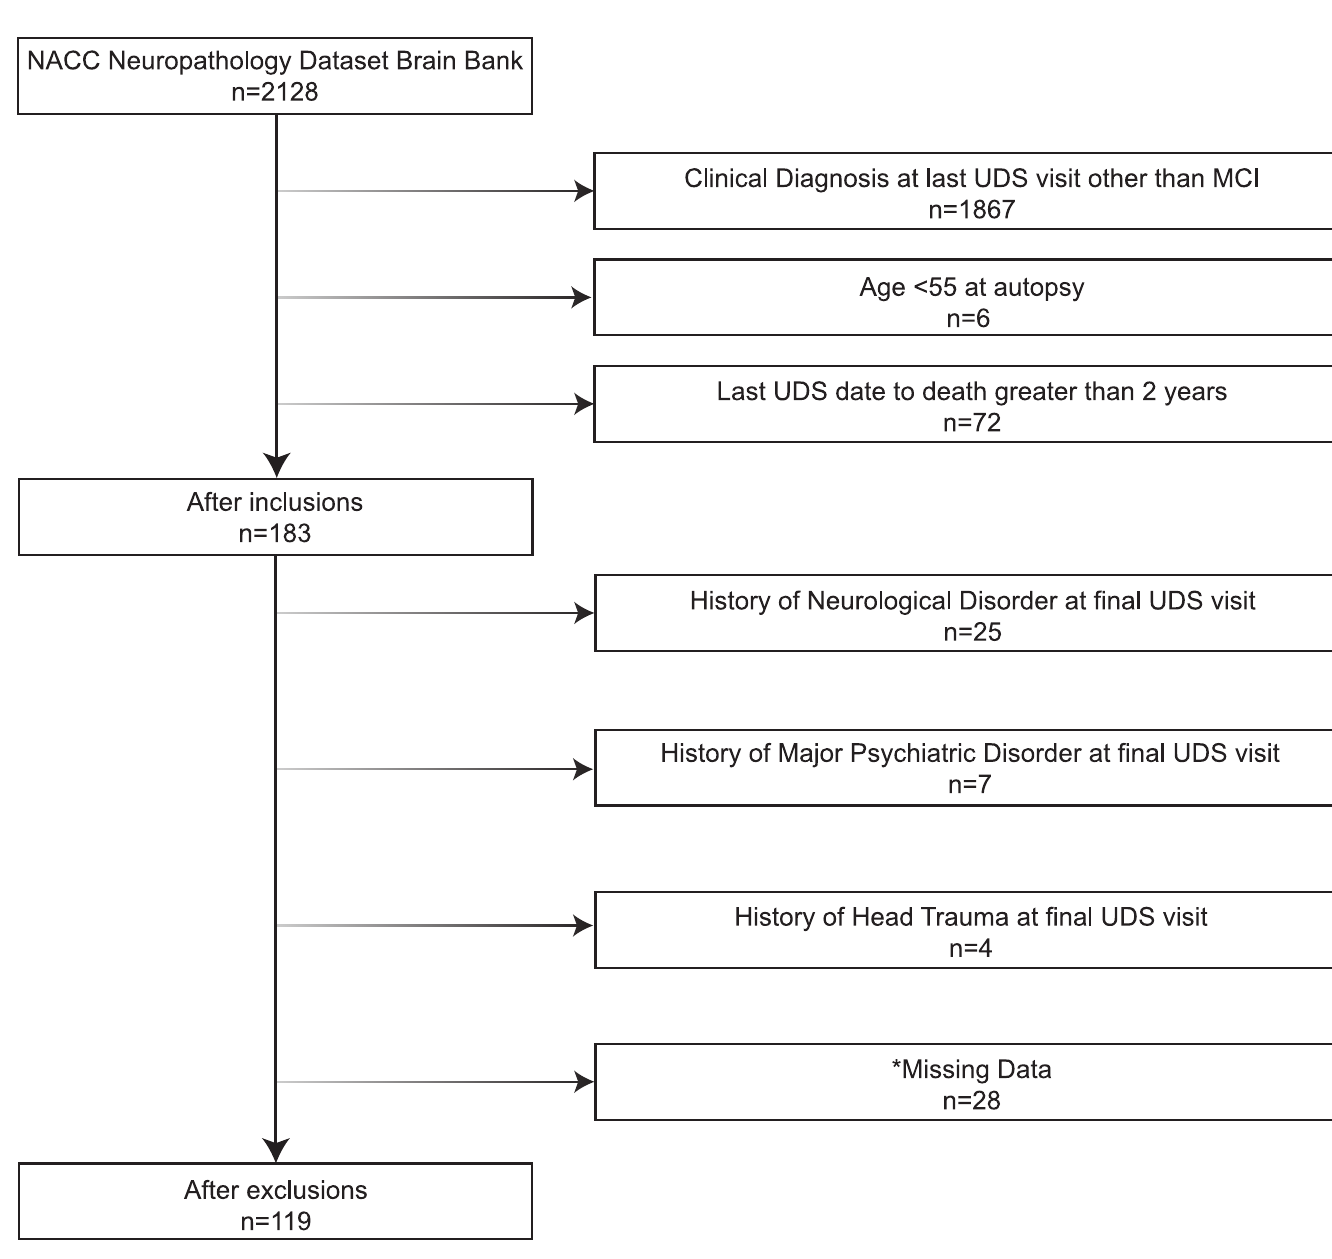
Fig 1. Participant Inclusion & Exclusion Details. Note: The exclusion numbers provided are not mutually exclusive; * = missing data includes demographic and clinical variables (i.e., race, education, depressed mood) and complaint status at last clinical visit.